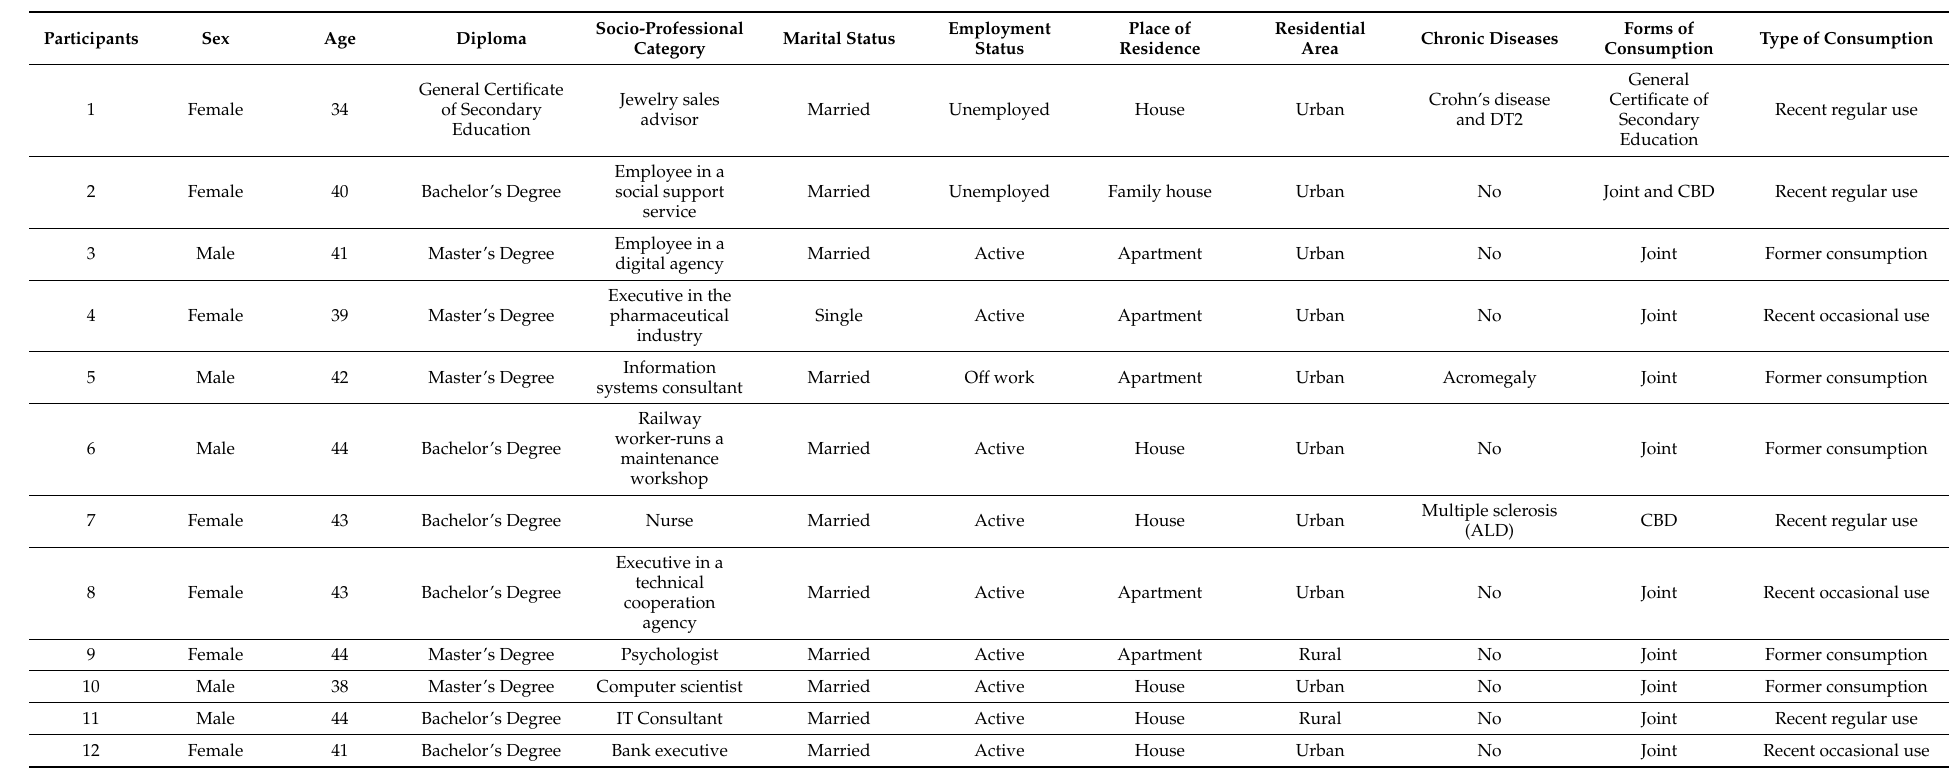
Table 1. Characteristics of the study